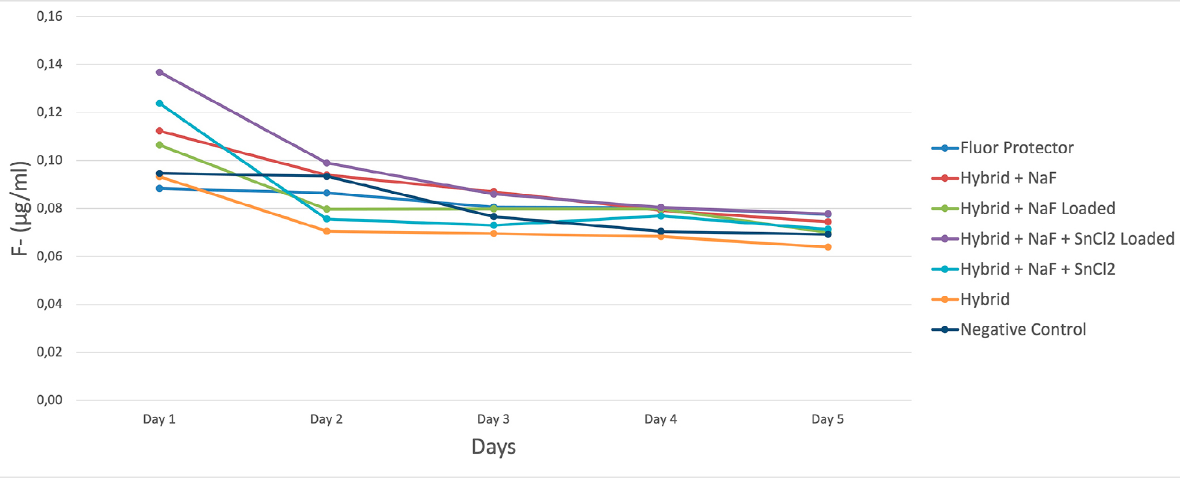
Figure 8- Fluoride release (µg/mL) over the cycling